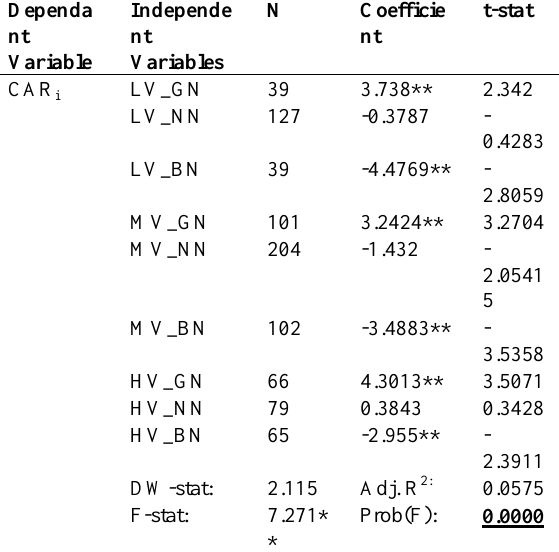
Table 8: Regression result for volatility and